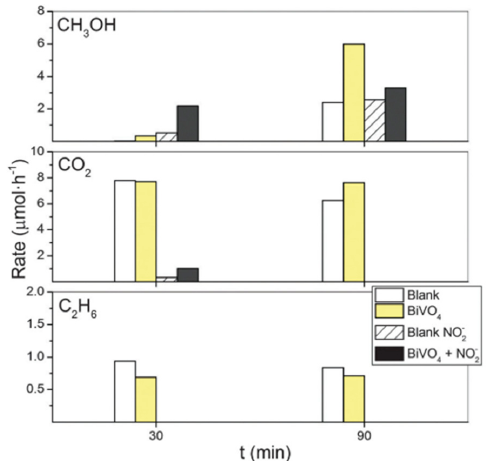
Figure 44. Production rate of methanol, ethane, and CO 2 by BiVO 4 at 30 and 90 min. Reproduced from [55] with permission from The Royal Society of Chemistry.